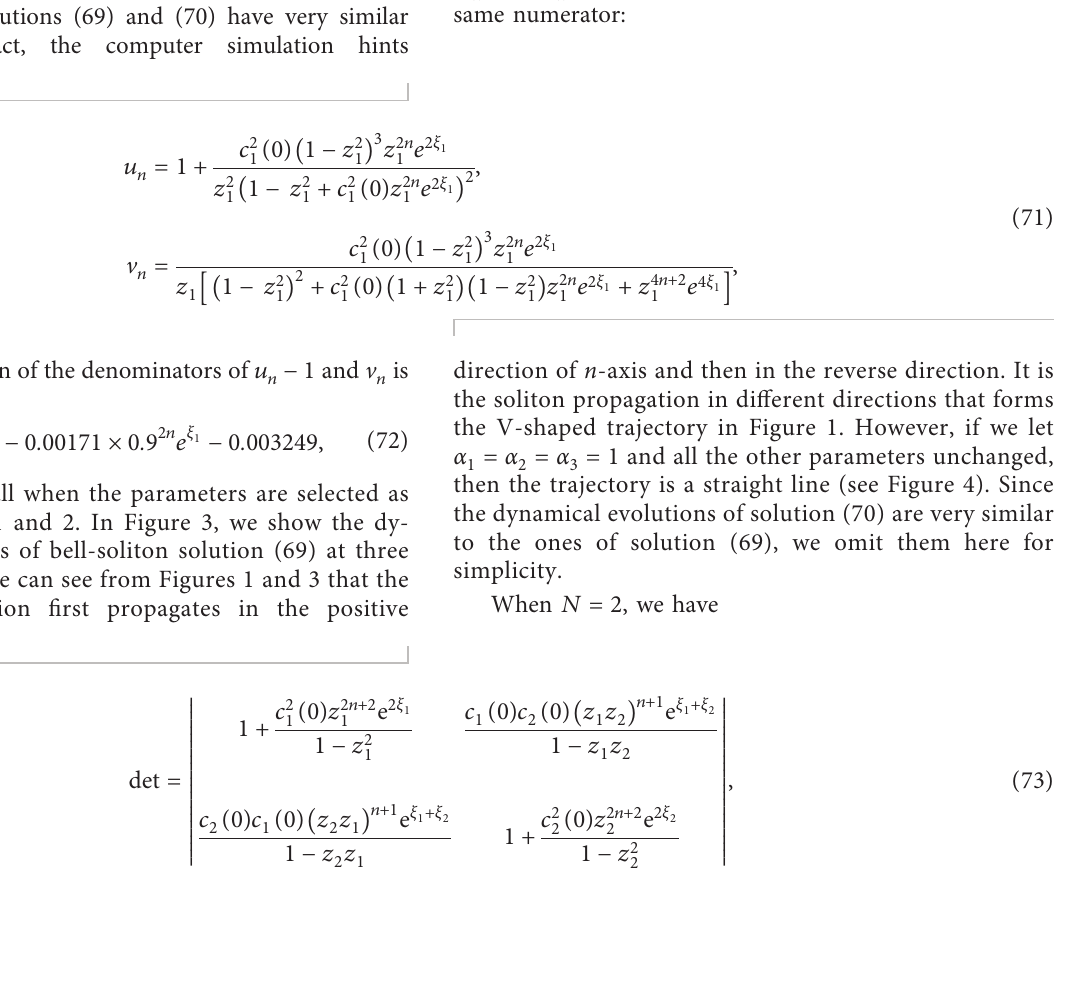
� 1, α � t , α � cos t , 0 1 2 � 0 . 9. 1